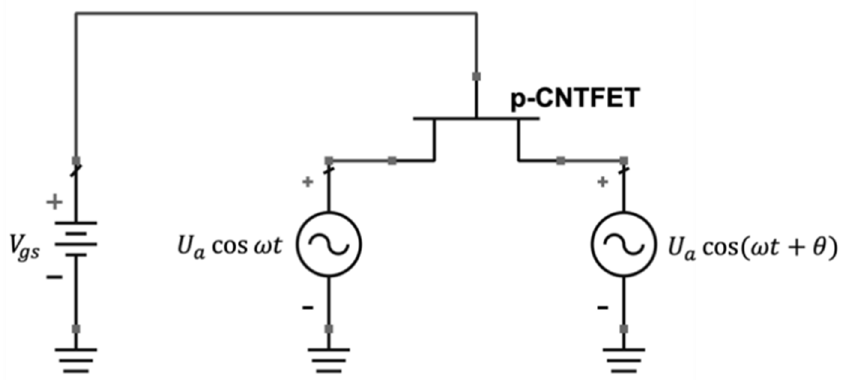
Figure 5. Schematic simulation circuit for the p-CNTFET spectrometer. The THz rectification voltage response is generated due to the asymmetric boundary conditions induced by the phase shift, Θ , between two THz signals applied to the source and drain at the gate bias, V gs .